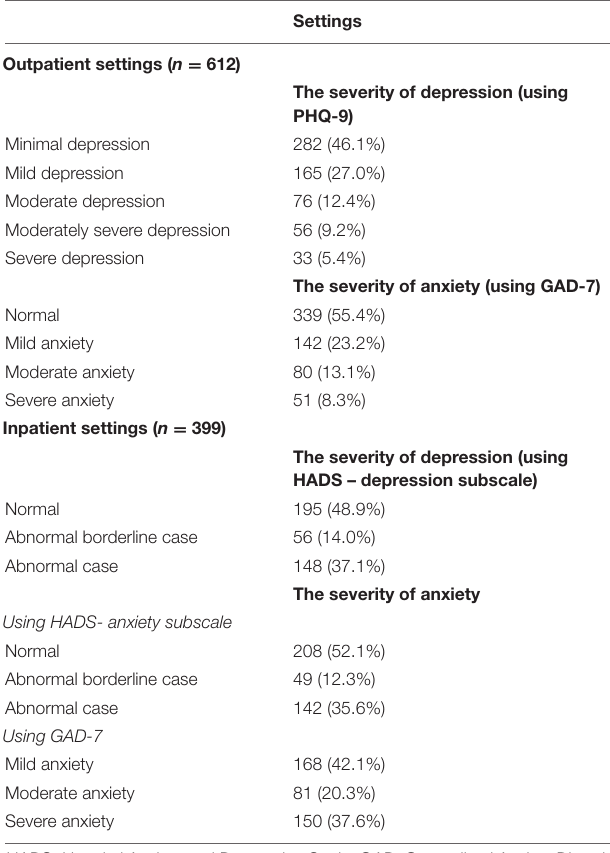
TABLE 2 | Prevalence of depression and anxiety among the patients’ stratified by